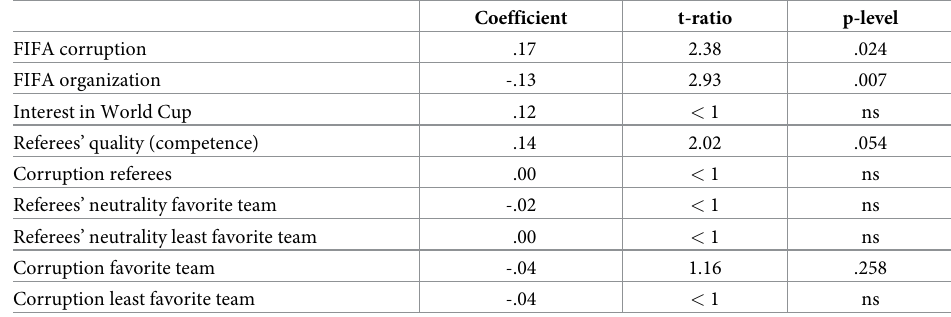
Table 3. Relationships between country level corruption (WB13) and perceptions of FIFA and the World